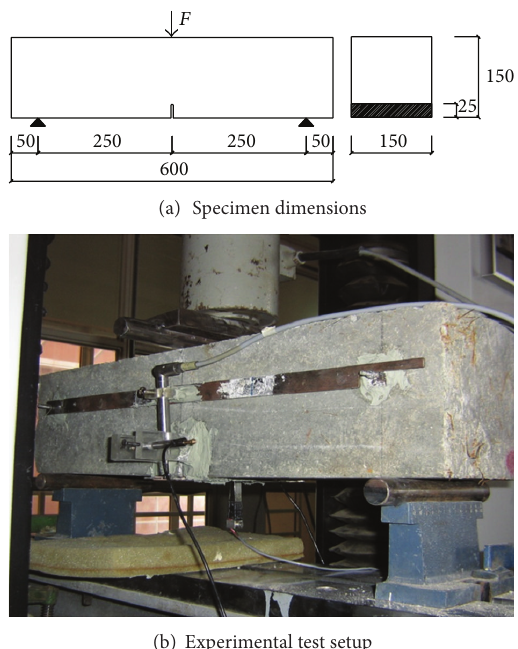
Figure 1: Three-point bending test.